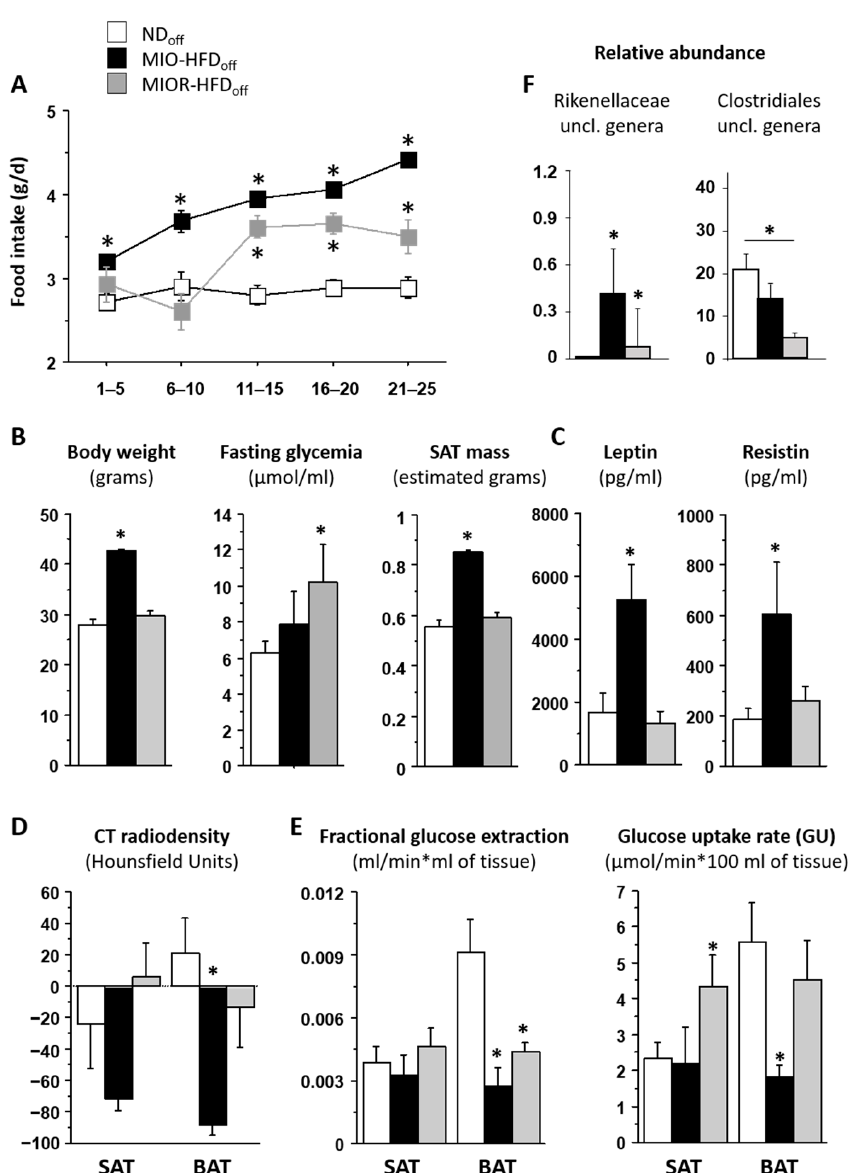
Figure 2. Phenotype of mice born to HFD or ND dams. The group of offspring born to HFD dams (HFDoff) is stratified according to the presence or absence of adulthood obesity (MIO, MIOR). Food intake, body weight, and metabolic and adipokine profiles are shown in ( A – C ); BAT and SAT lipid